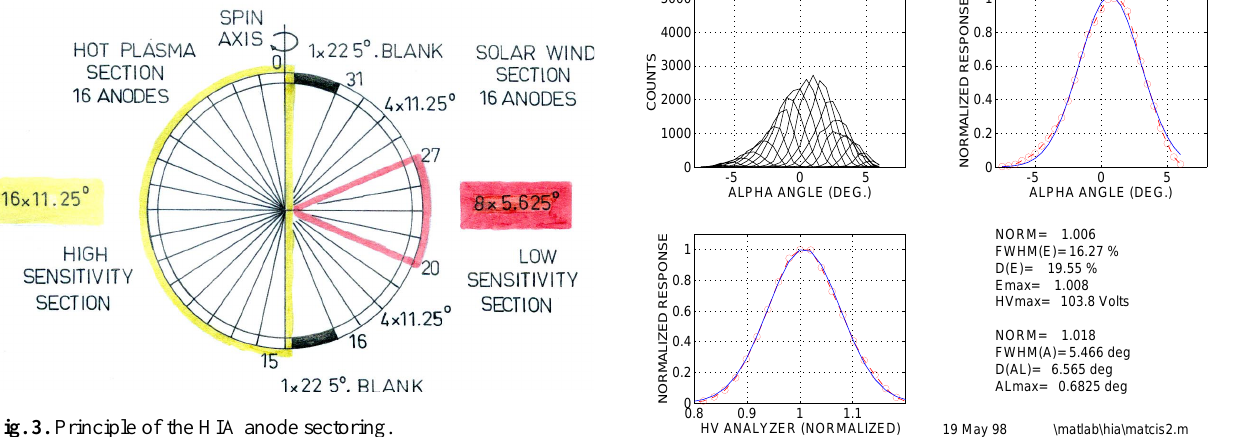
Fig. 3. Principle of the HIA anode sectoring.